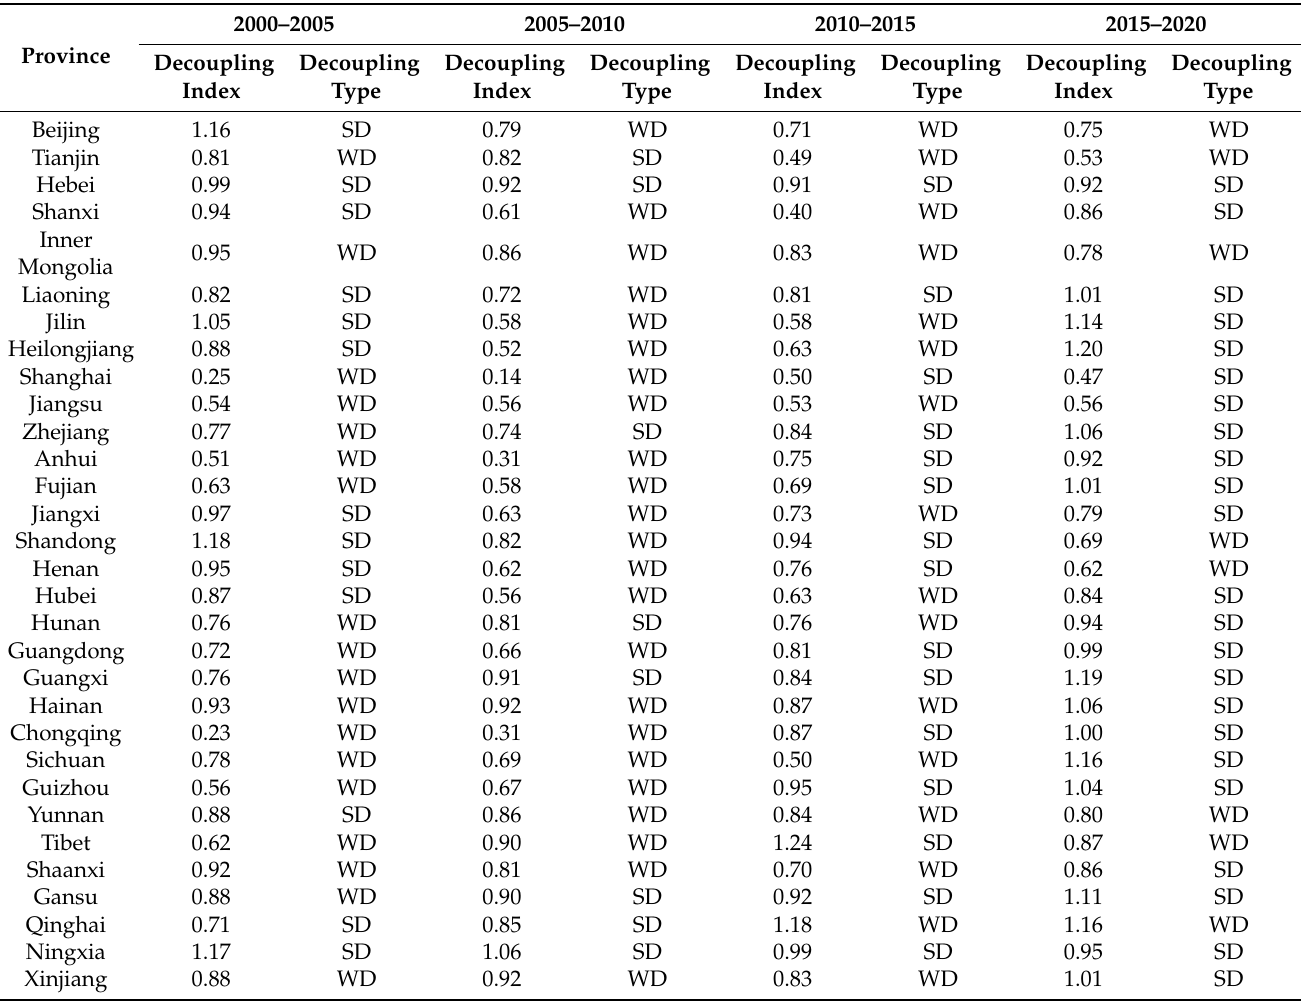
Table 4. Decoupling index and state of water usage and economic growth in each province.